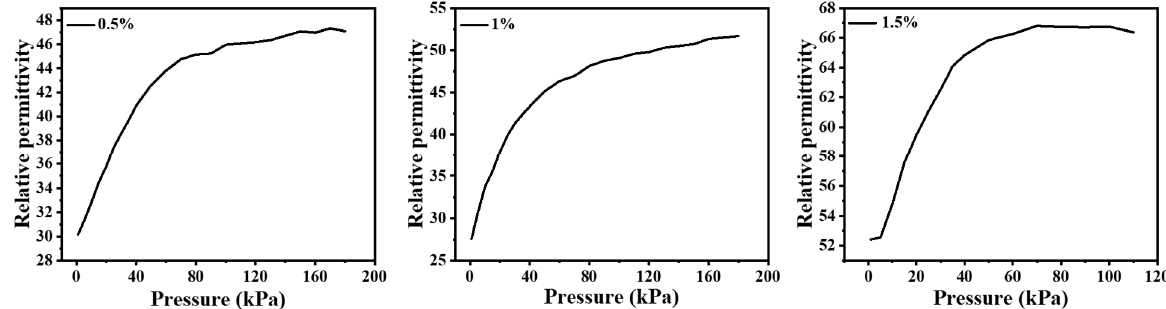
Figure 4. Relative permittivity of the PDMS/CNT nanocomposites with 0.5, 1, and 1.5 wt% CNT under different